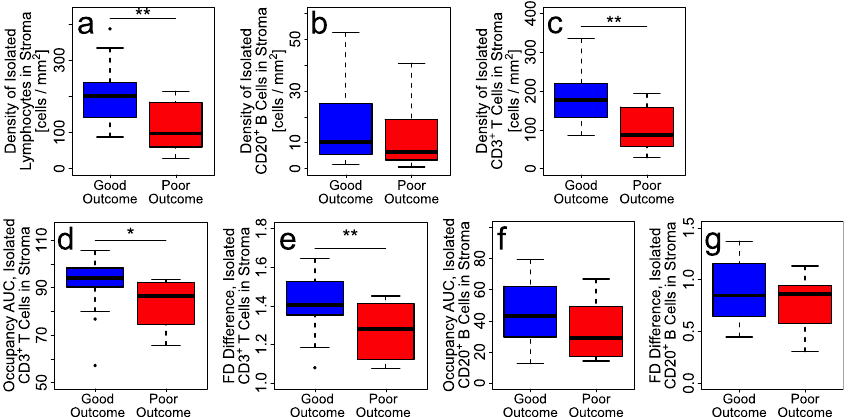
Fig. 5 Density and spatial dispersion of isolated lymphocytes and isolated CD3 + T cells within stroma are signi fi cantly higher for good outcome tumors, but not for isolated stromal CD20 + B cells. Density of isolated ( a ) lymphocytes, ( b ) CD20 + B cells, and ( c ) CD3 + T cells within stroma for good vs. poor outcome tumors. Plots of ( d ) occupancy AUC and ( e ) FD difference of isolated CD3 + T cells within stroma showing greater spatial dispersion in good compared to poor outcome. Plots of ( f ) occupancy AUC and ( g ) FD difference showing that spatial dispersion of isolated B cells within stroma is not signi fi cantly different between good vs. poor outcome. Patient cohorts for plots in this fi gure are n = 24 for good outcome (blue) and n = 12 for poor outcome (red). For all box-and-whisker plots, the center line represents the median, box limits represent the upper and lower quartiles, whiskers indicate maximum and minimum values within 1.5 interquartile ranges of the upper and lower quartiles; individual points are outliers. P -values in box plots are determined by unpaired, two-tailed Student t -tests. ns: not signi fi cant; * p < 0.05; ** p < 0.01; *** p < 0.001; **** p < 1 × 10 − 4